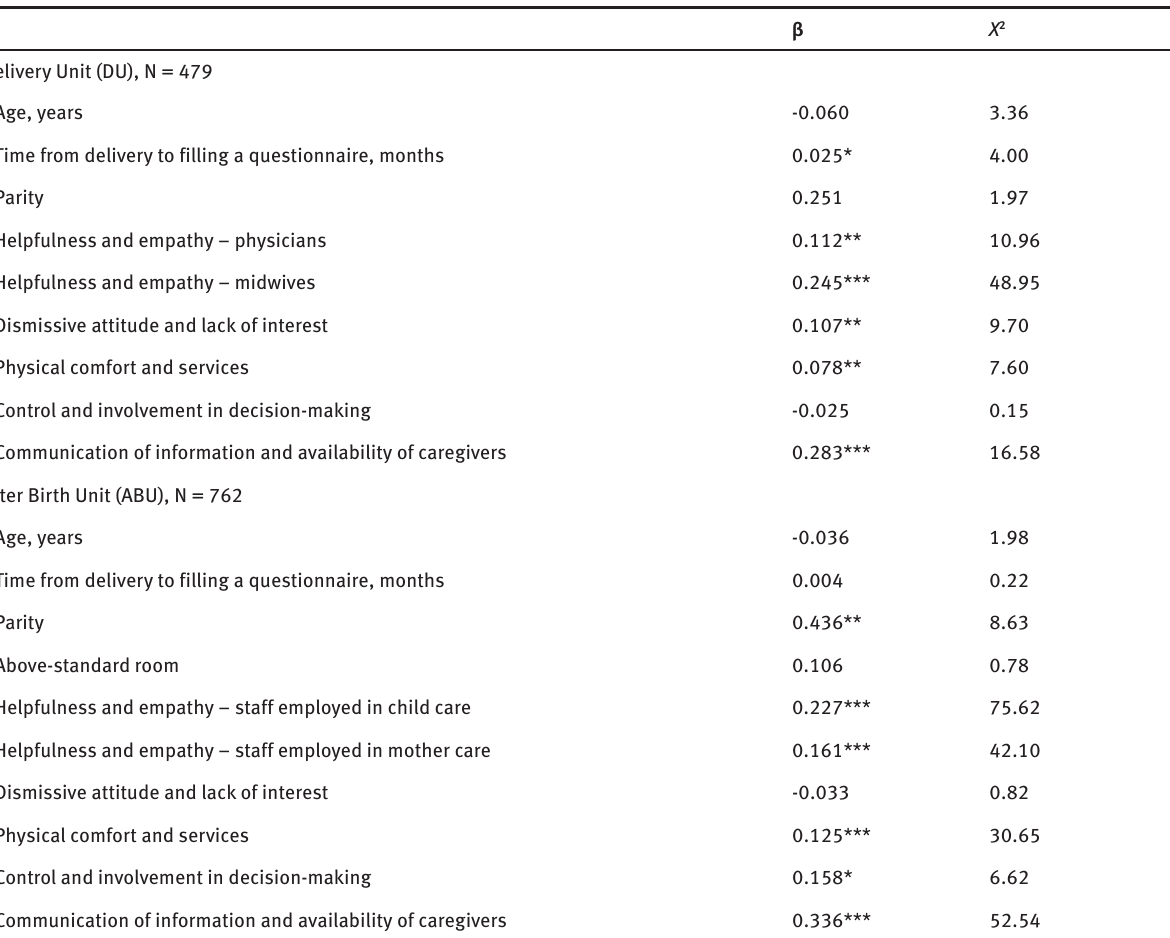
Table 2 : Predictors of satisfaction with care (model 1, model 2)